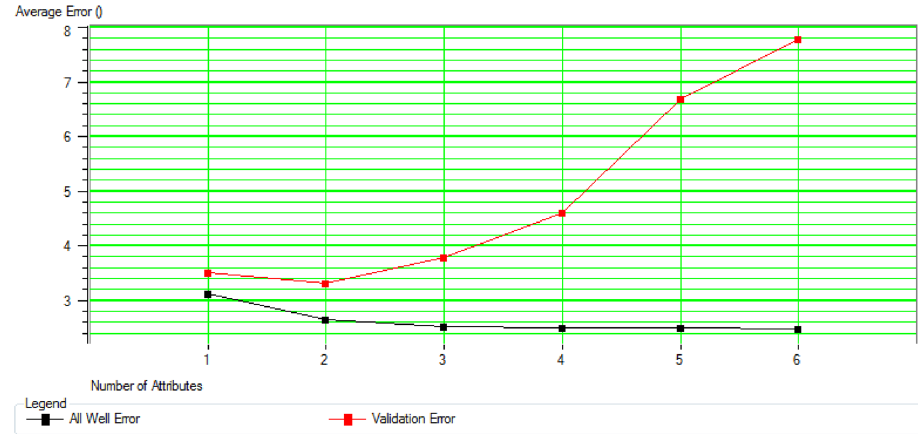
Fig. 32 Results of multi- attribute regression for the third category of data